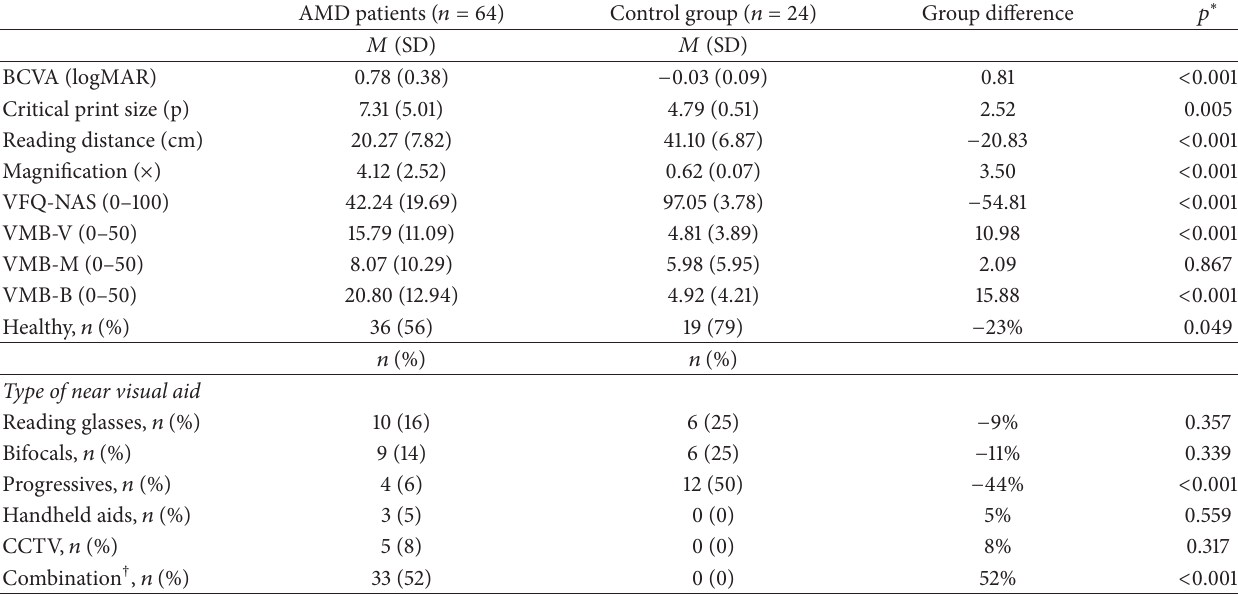
Table 1: Descriptive statistics of AMD patients and reference group at baseline.